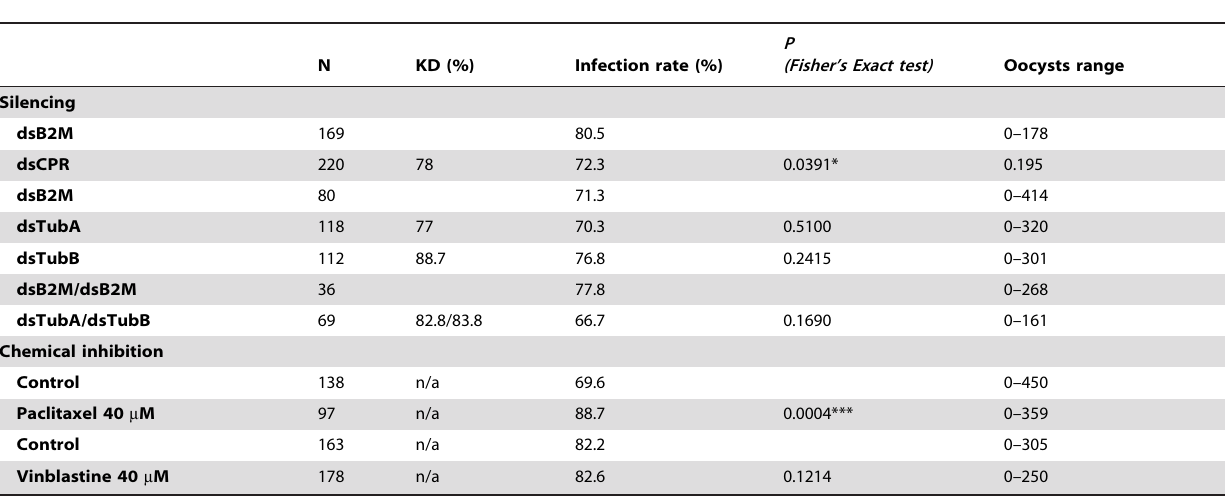
Table 1. Effect of silencing CPR , tubA , tubB or co-silencing tubA and tubB and effect of injecting tubulins inhibitors on P. berghei infection in the